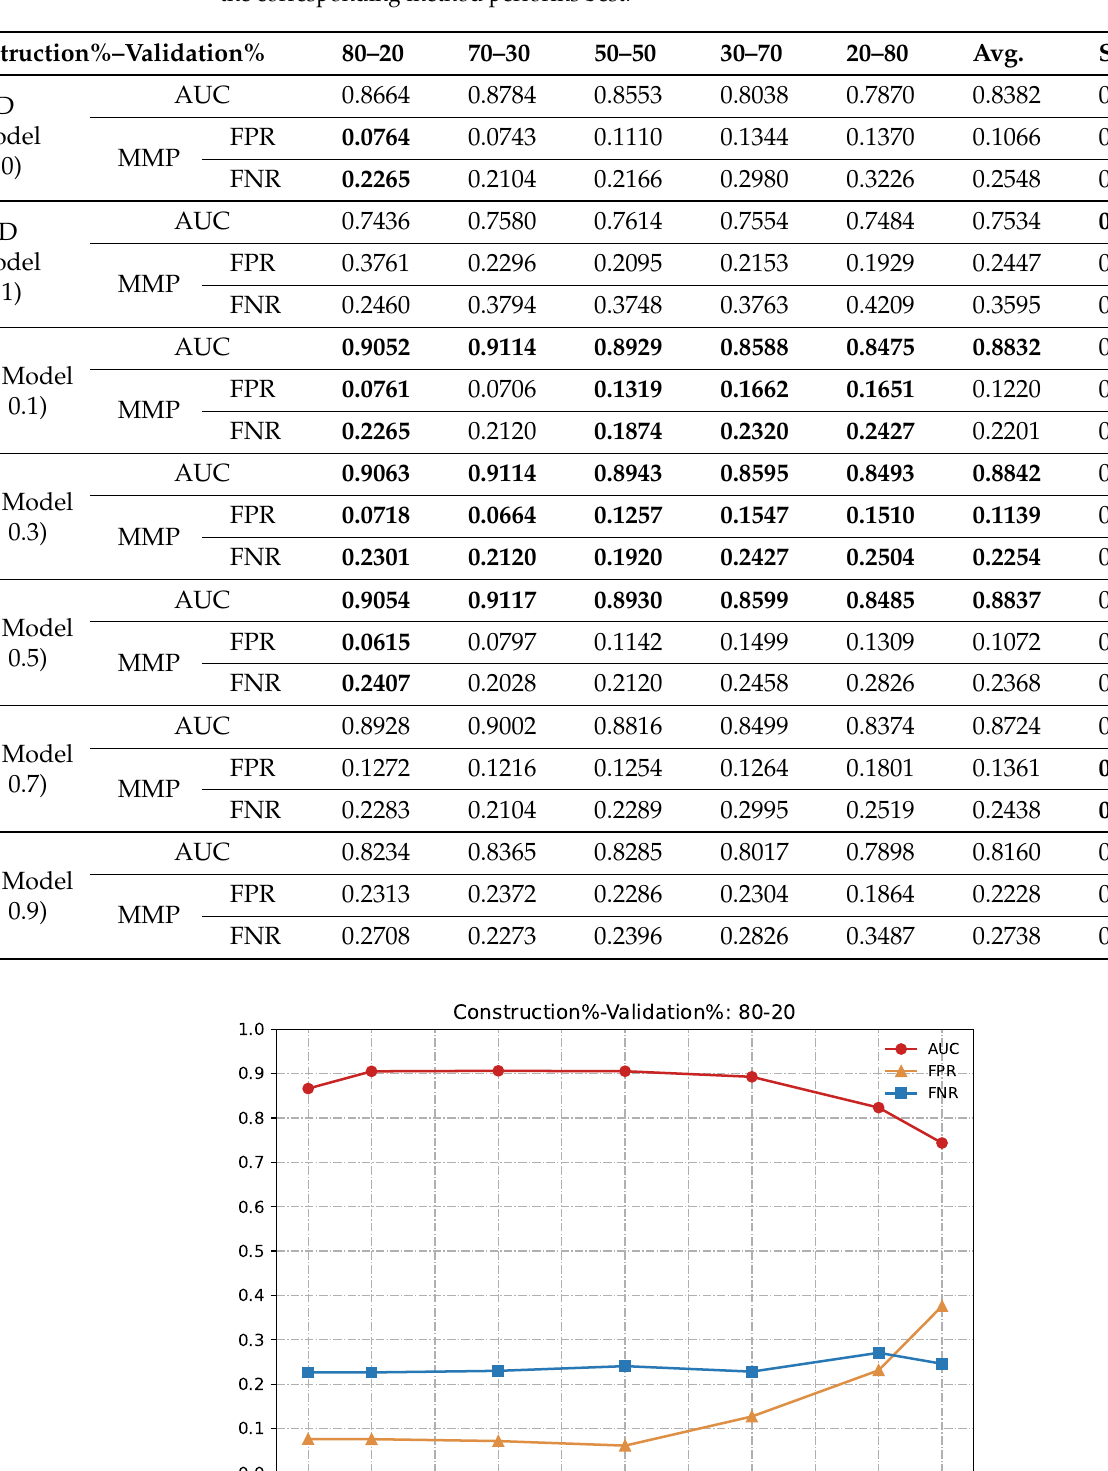
Table 2. Overall anomaly detection performance in terms of AUC and MMP. A number in bold means the corresponding method performs best.